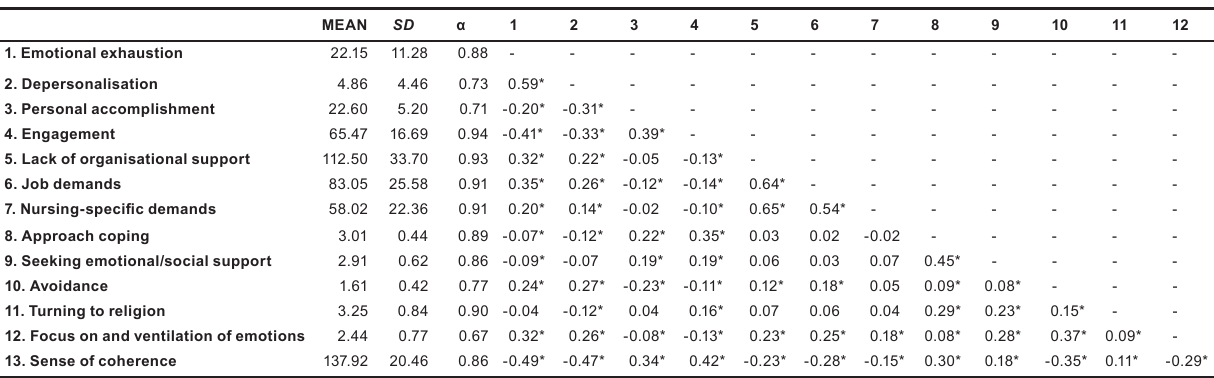
TABLE 2 Descriptive statistics, alpha coefficients and Pearson correlations between the scales